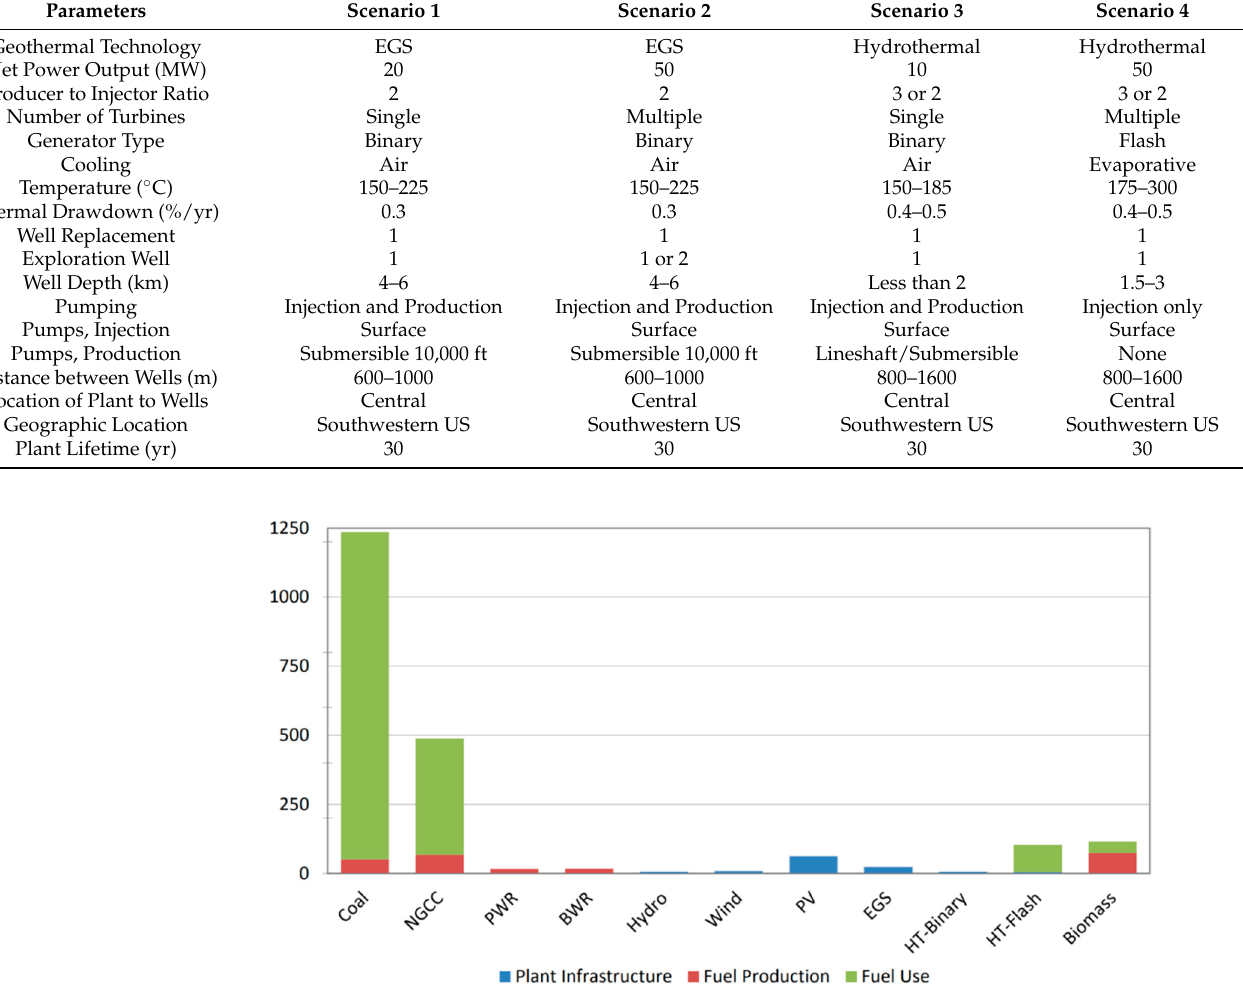
Figure 6. GHG emissions (gCO 2 eq/kWh) by life cycle stage for various power-generating technolo- gies as determined in GREET 2.7 [29].